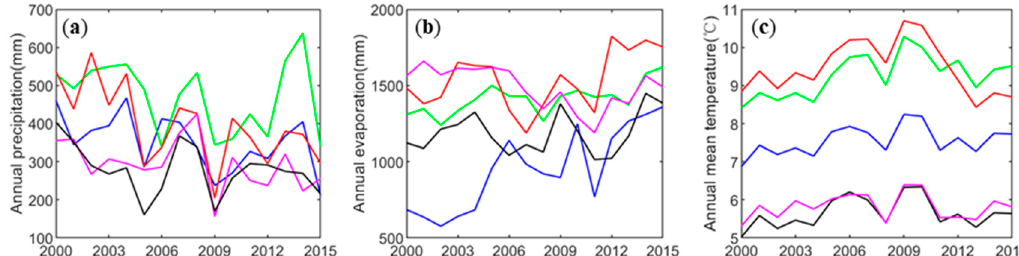
Figure 9. Annual precipitation ( a ), lake surface evaporation ( b ), and mean temperature ( c ), in 2000–2015, derived from five metrological stations near Yamzho Yumco. The different color lines in the three charts represent variables of different stations.